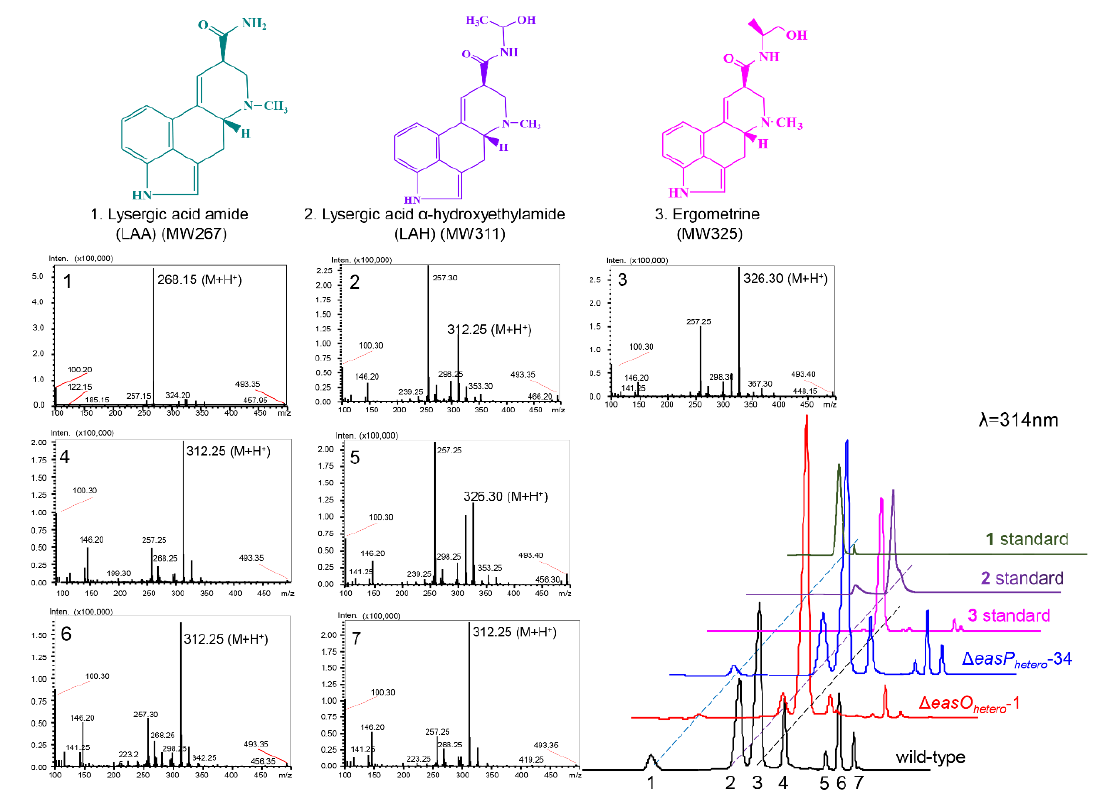
Figure 4. LC ‐ MS analysis of fermentation products of Δ easO hetero ‐ 1, Δ easP hetero ‐ 34 and the wild ‐ type Figure 4. LC-MS analysis of fermentation products of ∆ easO hetero -1, ∆ easP hetero -34 and the wild-type strain. Notes: Ergot alkaloids might convert into their isomers. 1, LAA; 2, LAH; 3, ergometrine; 4, 6 and 7, isomers of LAH; 5, isomer of ergometrine. The standards of ergometrine, LAH and LAA were used, respectively.